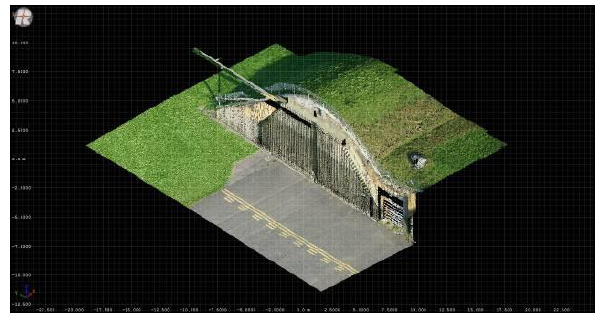
Figure 6: Section of the LiDAR point cloud representing the airplane hangar in Fig. 5 after post-processing.